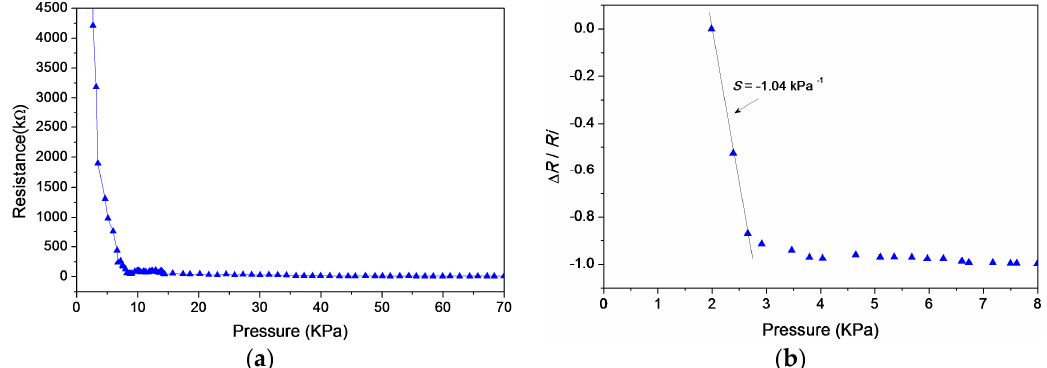
Figure 7. ( a ) Measured piezoresistive response of the tunneling sensor; ( b ) Normalized measured response under 8 kPa.